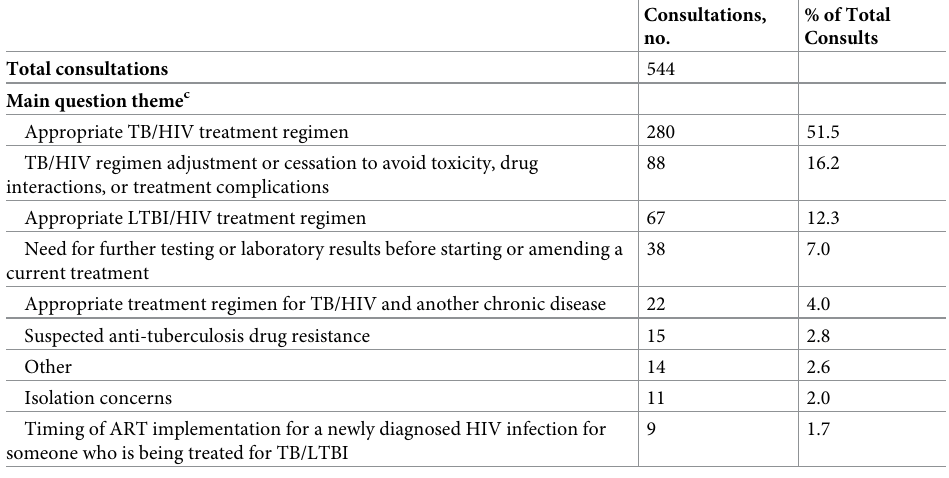
Table 3. Summary of main question themes among TB/HIV consultations a received by all Regional Training And Medical Consultation Centers (RTMCCs) b , 2013–2017.